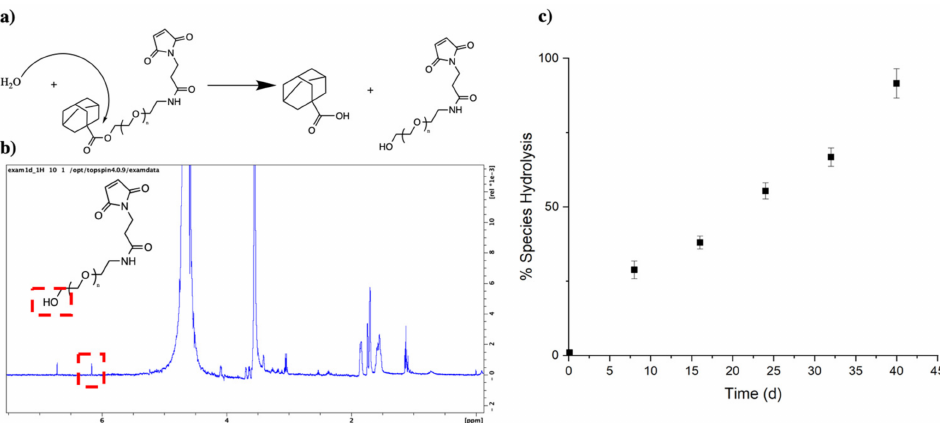
Figure 4. ( a ) Hydrolysis mechanism for PEG–Ad; ( b ) 1 H NMR (D 2 O) with Bruker 300 MHz, noting a hydrolysis peak at δ = 6.1 ppm and a reference peak at δ = 4.2 ppm ( − CH 2 − ); and ( c ) a species percentage was quantitively obtained from hydrolysis peak δ = 6.1